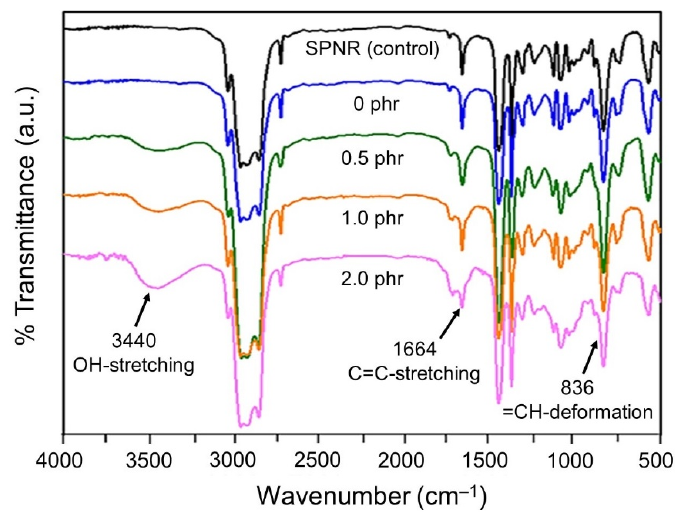
Figure 5. FTIR spectra of SPNR and samples with various TiO 2 contents in the presence of 20% w / w H 2 O 2 after UVC-irradiation for 5 h.